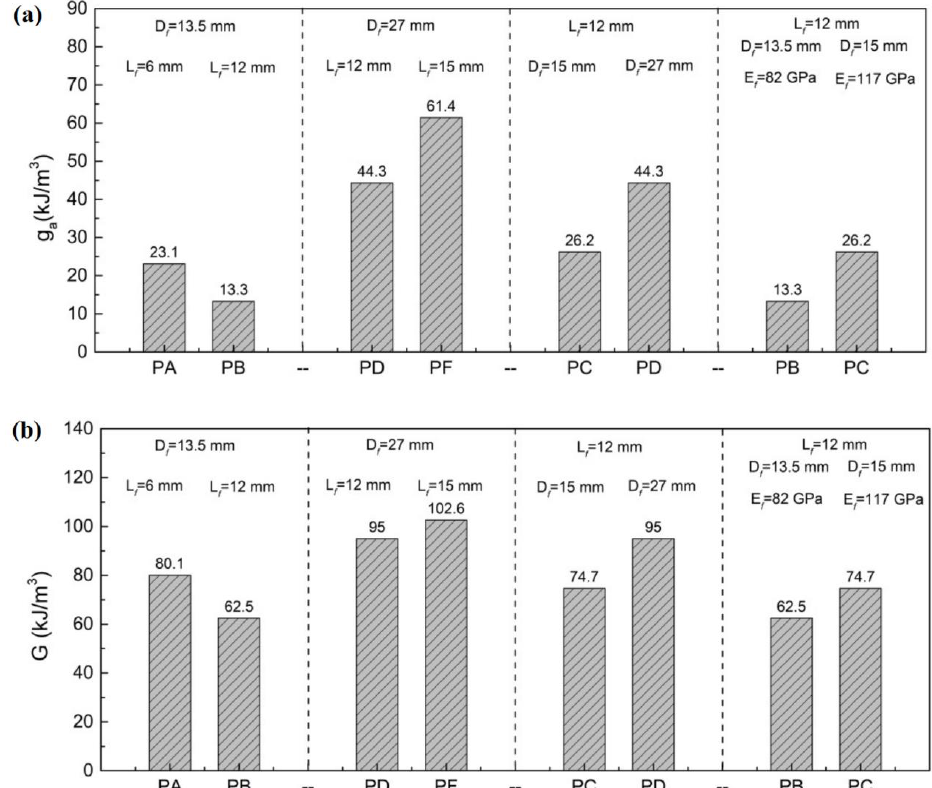
Figure 15. ( a ) Energy absorption capacity of UHPC with PE fiber before strain softening; ( b ) Overall energy absorption capacity of UHPC with PE fiber.